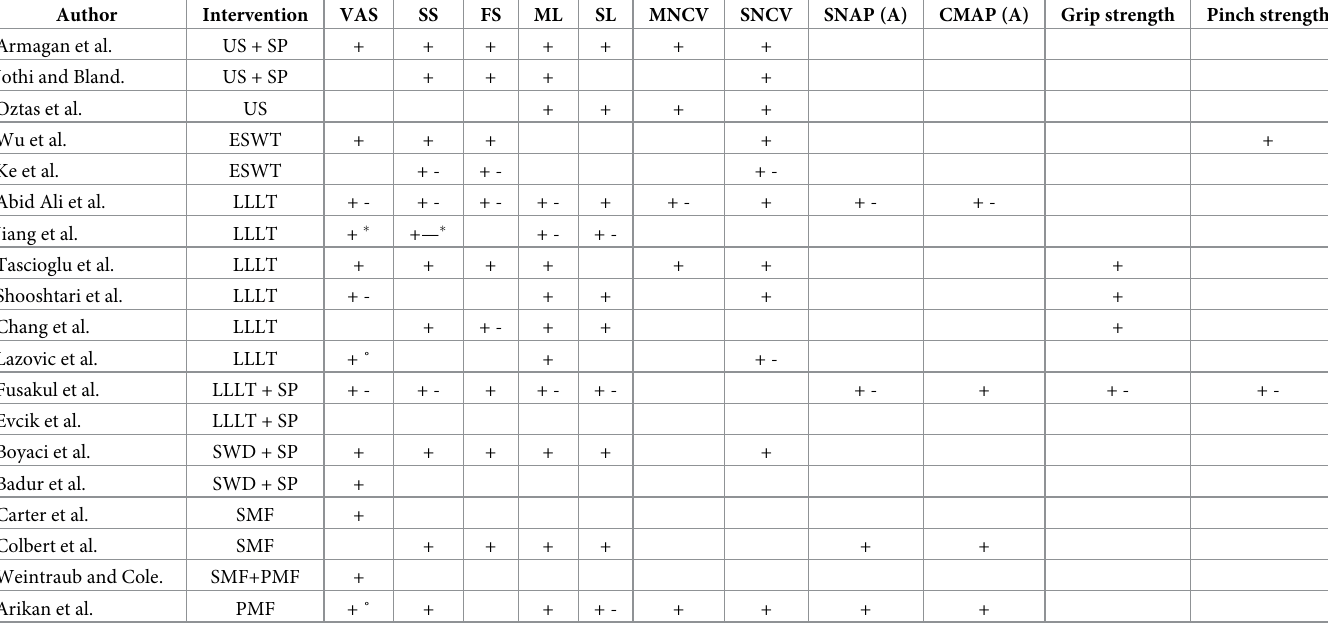
Table 1. Outcome measures and significance of electrophysical modalities versus placebo.